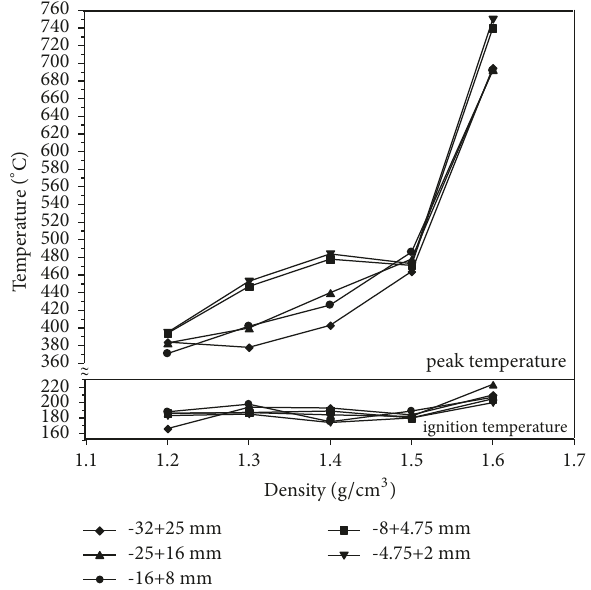
Figure 6: The ignition and peak temperatures of floated materials for all fractions at different specific gravities of medium.